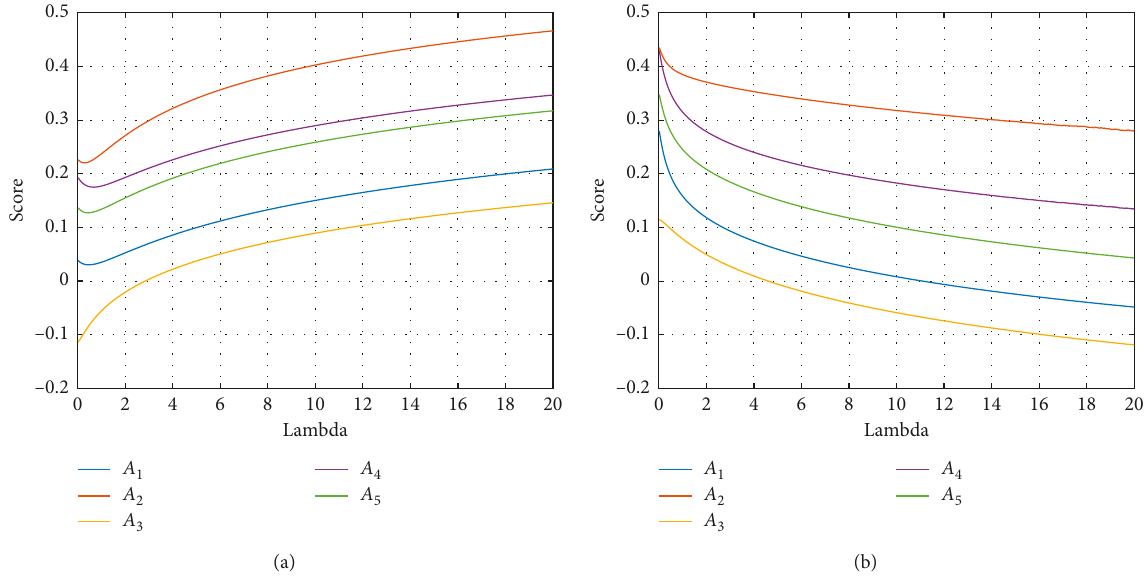
Figure 2: The results of Experiment 3. Scores of the five companies calculated by (a) qROFWAHMM and (b) qROFWAHGMM.